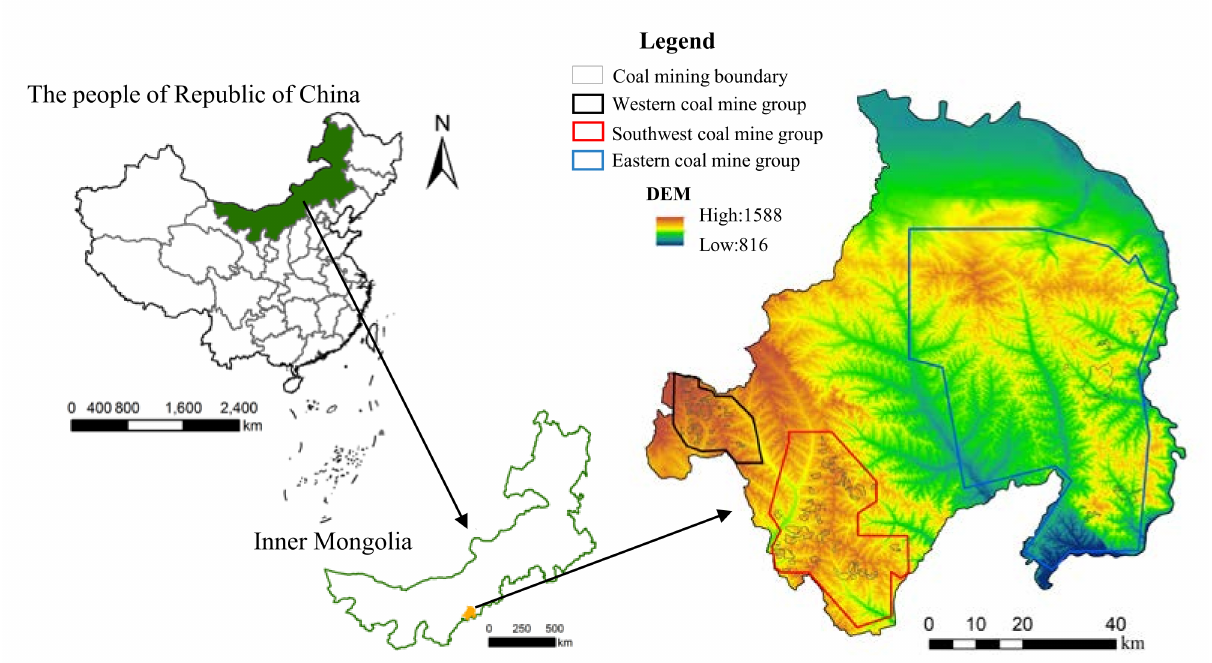
Figure 2. Location of the study area and geographic distribution of open-pit coal mining groups in Jungar